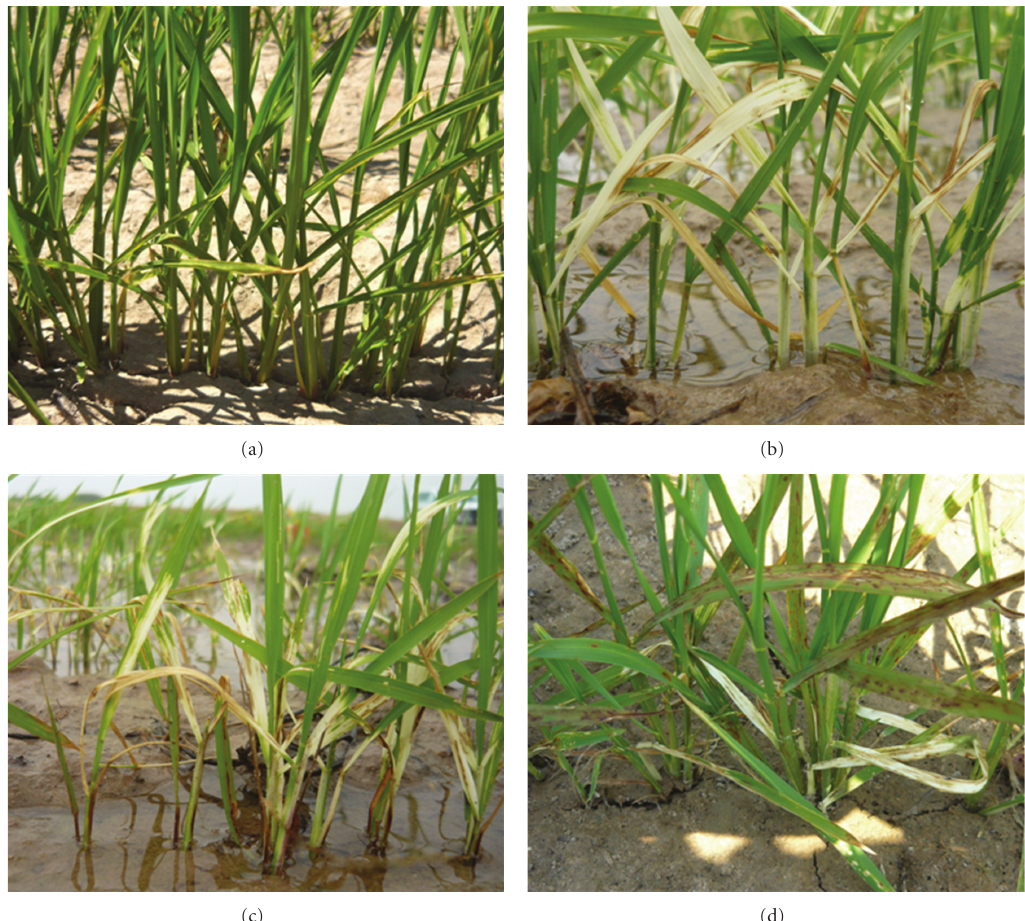
Figure 1: Rice symptoms from clomazone alone (b), clomazone plus saflufenacil applied preemergence (c), and postemergence (d). Untreated check is represented in box (a). Pictures were taken in di ff erent rice